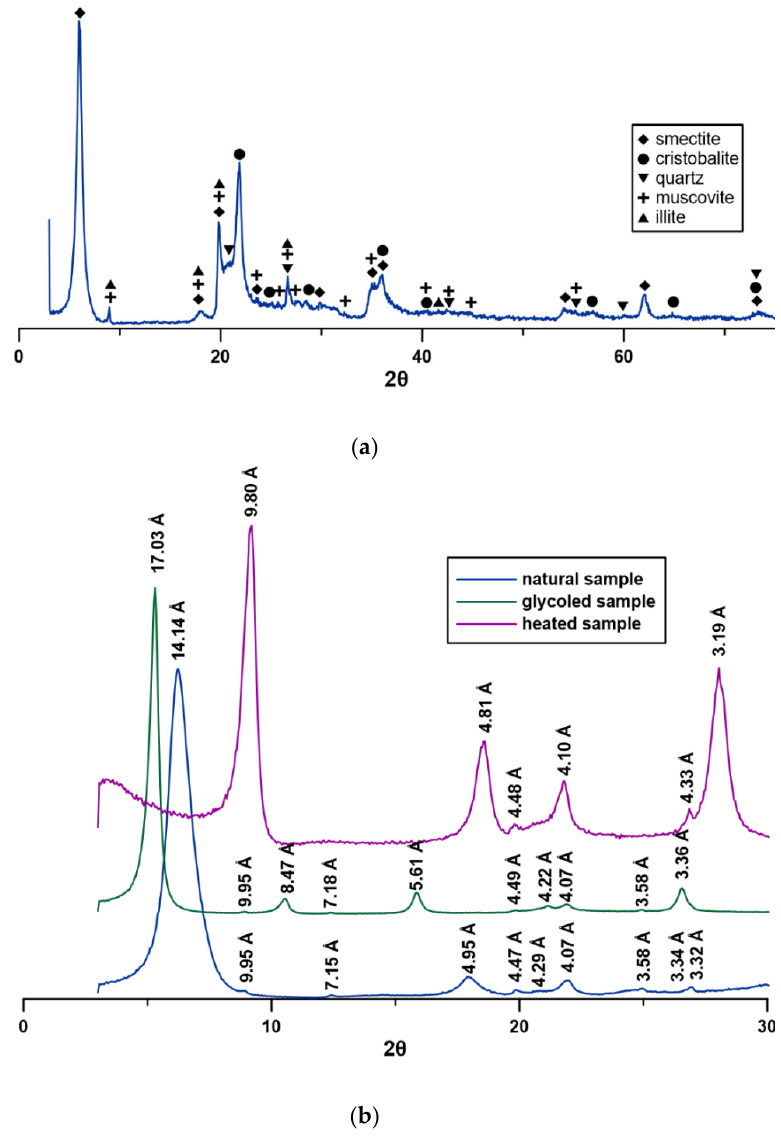
Figure 1. X-ray diffraction patterns of bentonite. ( a ) Mineralogical composition, ( b ) oriented Figure 1. X-ray di ff raction patterns of bentonite. ( a ) Mineralogical composition, ( b ) oriented samples.